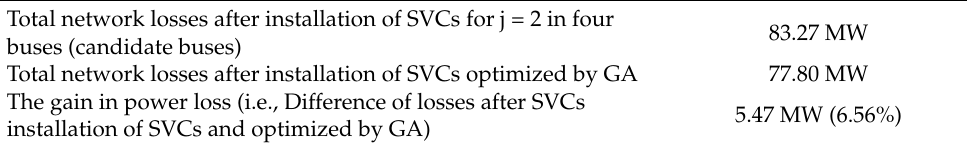
83.27 MW 5.47 MW (6.56%)